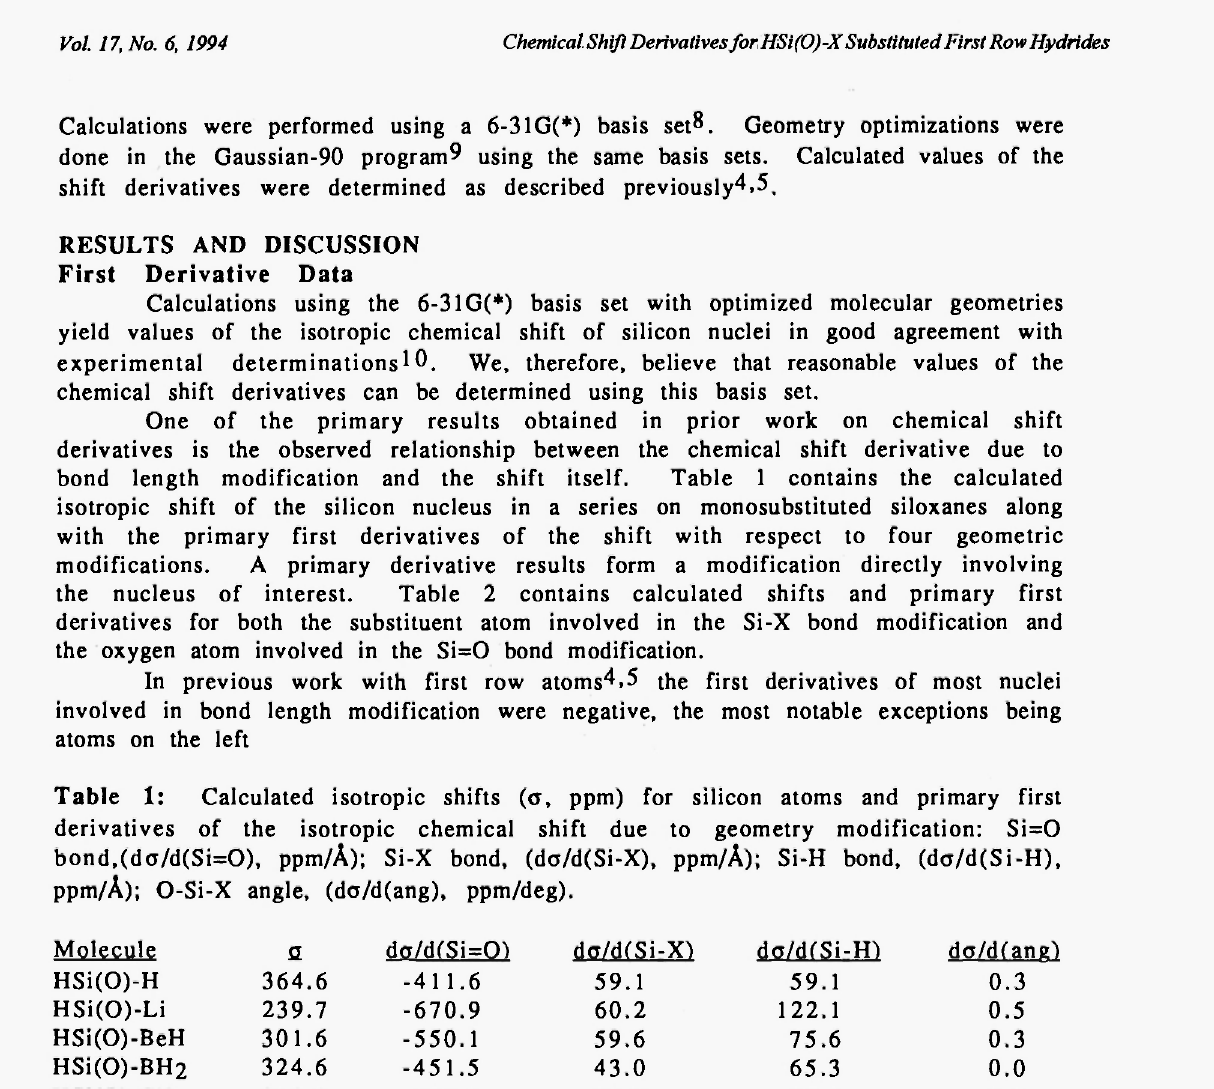
Calculated isotropic shifts (σ, ppm) and primary first